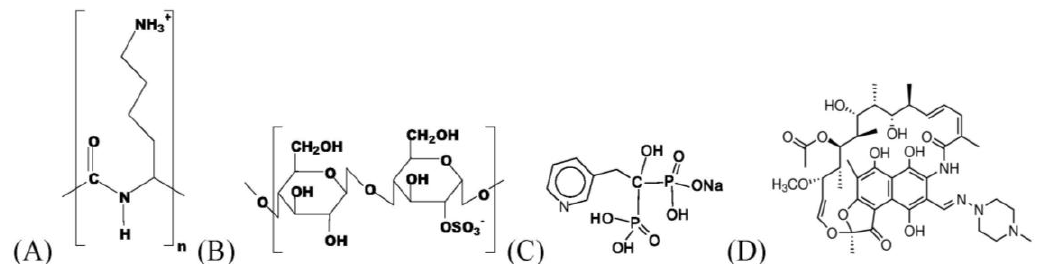
Figure 1. Scheme of the mainly used chemical compounds: Poly(l-lysine) (PLL) ( A ); Cellulose sulfates (CS-0.5) ( B ); Risedronate (RIS) ( C ); Rifampicin (RIF) ( D ).